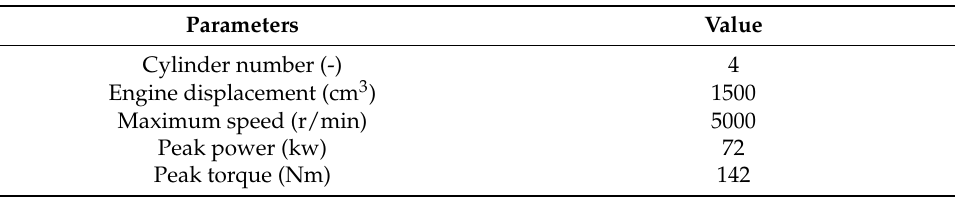
Figure 5. Fuel consumption rate map of the range extender (fuel consumption in red and engine power in black).